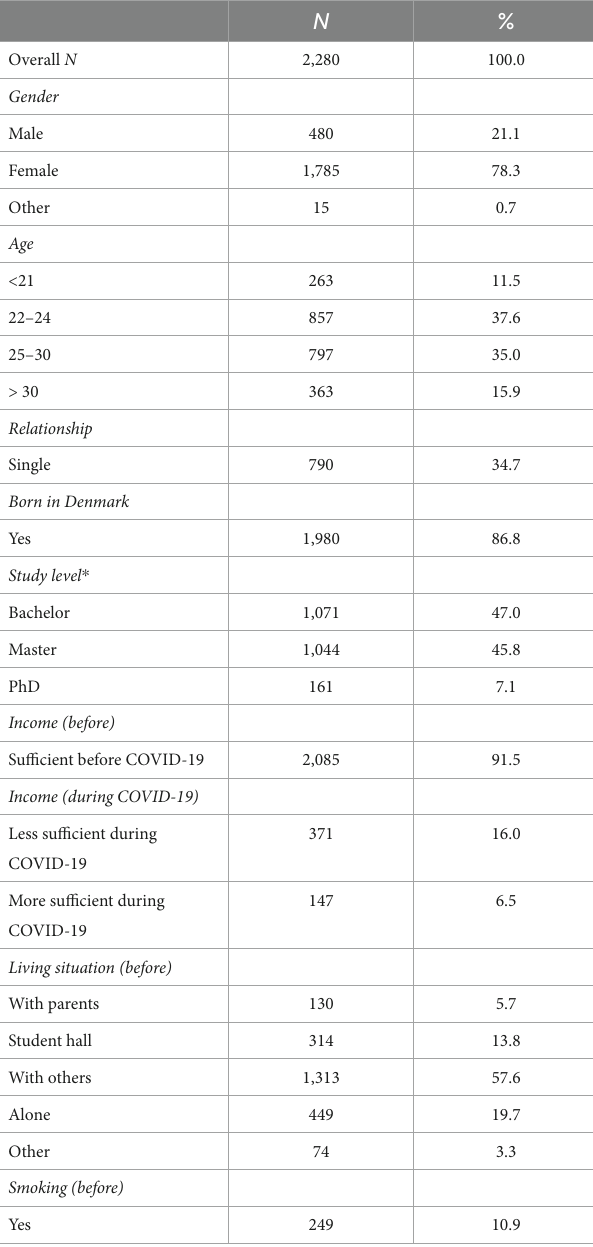
(Supplementary data, Table A1). Participants remaining at a stable level are characterized by a higher proportion being in a relationship, having sufficient and stable income and higher study level. Those who either decreased or increased were more likely to be of younger age, single, study at bachelor level, and experience changes in income. Among those increasing their physical activity level, a higher proportion had increased income during COVID-19 compared with other groups.